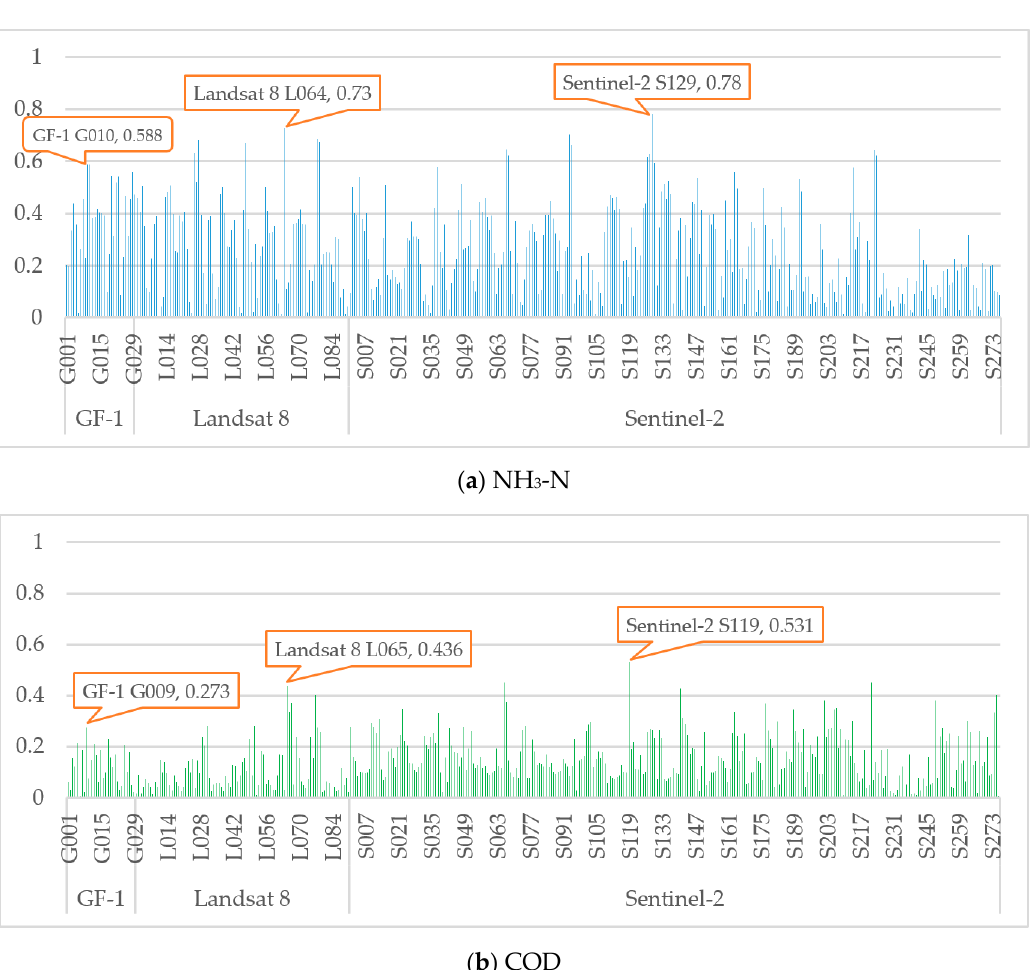
Figure 10. Distribution of the correlation coefficient between different band combinations and water quality parameters (NH 3 -N, COD and TP). The X -axis is the number of single bands and band combinations. G001, G002, ⋯ , G028 and G029 are the numbers of the four multispectral bands and band combinations of the GF-1 satellite. L001, L002, ⋯ , L090 and L091 are the numbers of the seven multispectral bands and band combinations of the Landsat 8 satellite. S001, S002, ⋯ , S275 and S276 are the numbers of the seven multispectral bands and band combinations of Sentinel-2 satellite. The Y -axis is the R value. The labels in the figure are the band combination numbers and R values of the